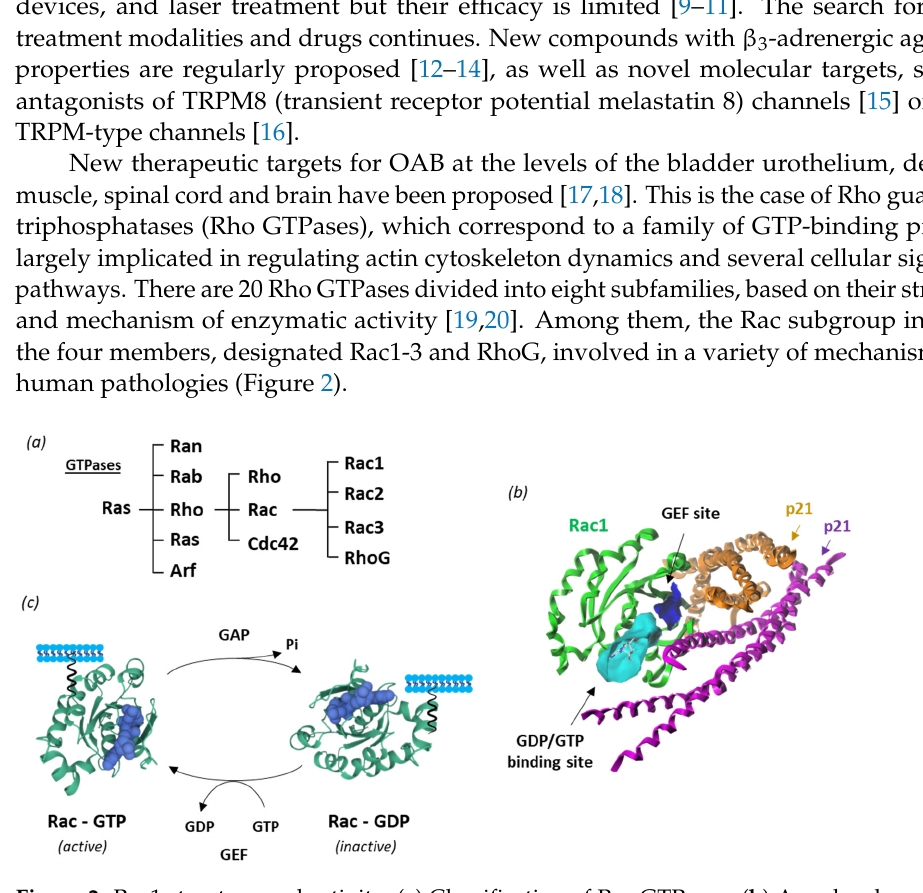
Figure 1. Anatomy of the bladder and the main associated pathologies.